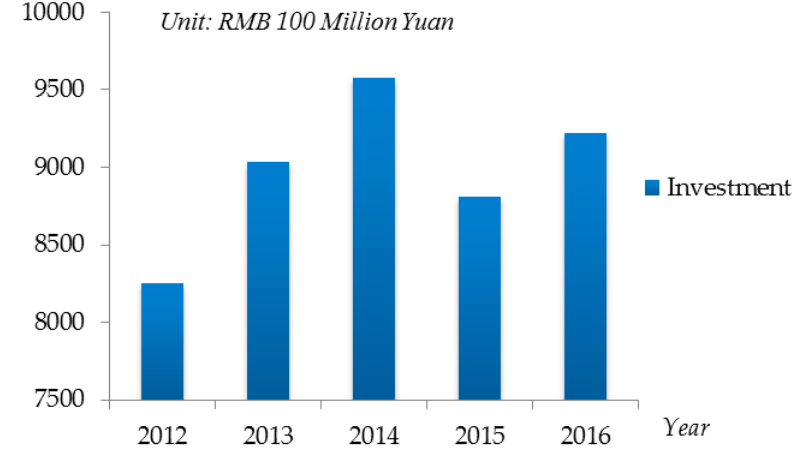
Figure 1. The per year investment in environmental pollution emergency management from 2012 to 2016, China.